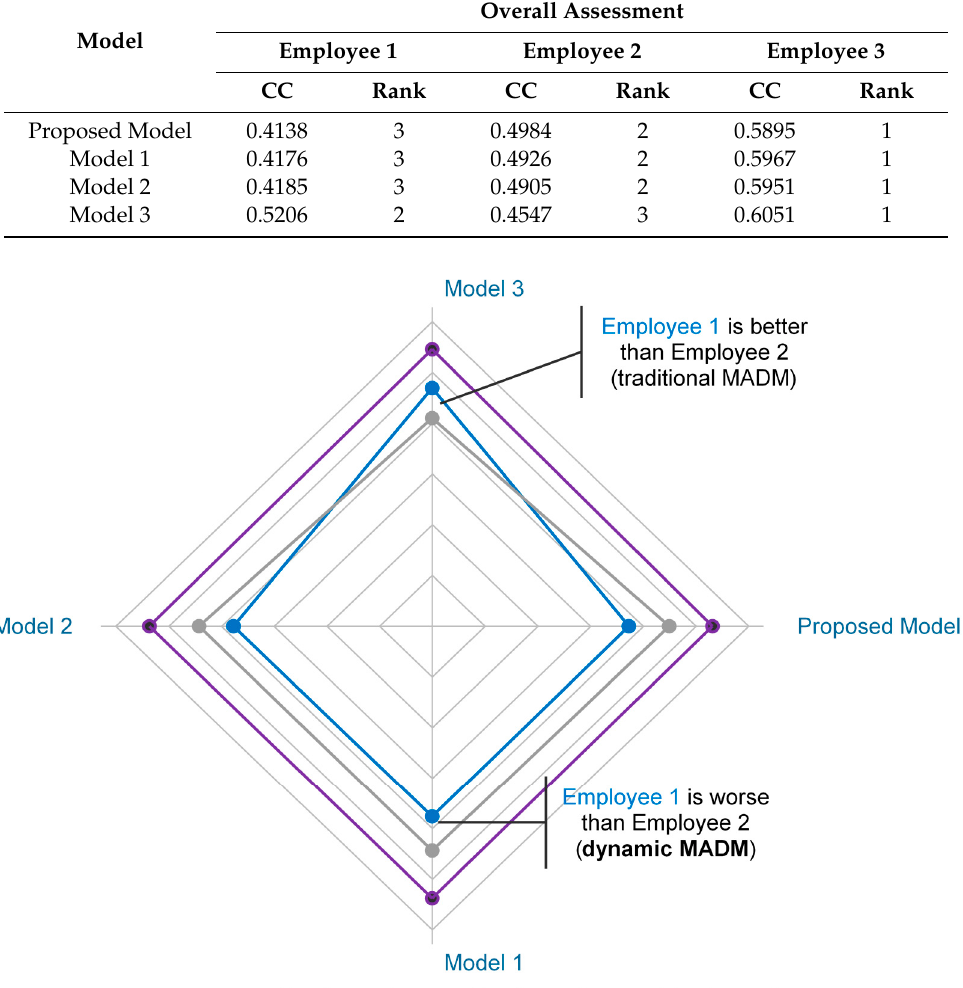
Table 15. Overall results.